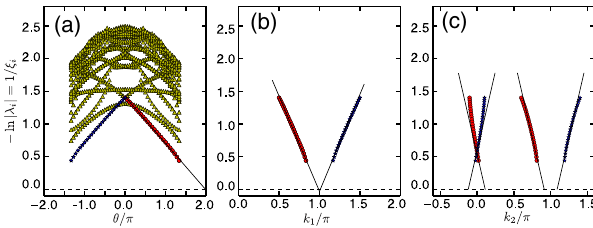
FIG. 14. The S z ¼ 1 transfer matrix spectrum of YC8-0; here, J ¼ 0 , and the bond dimension is m ¼ 6000 . 2